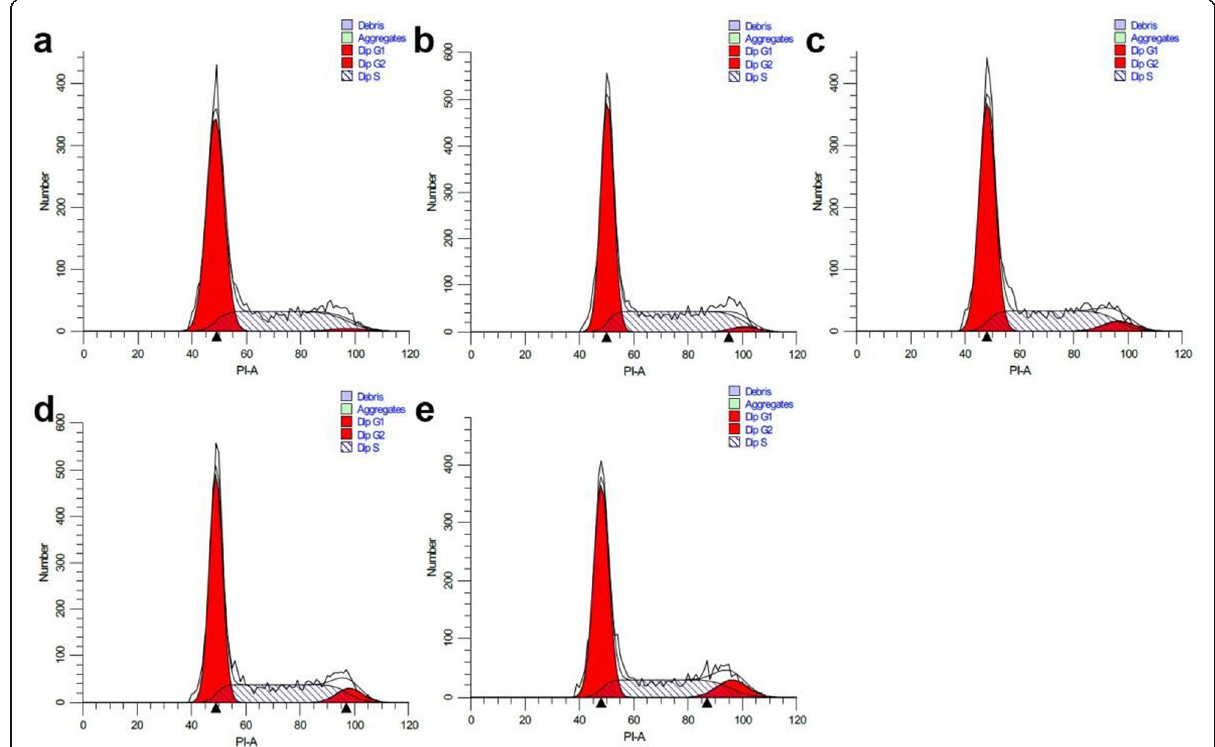
Fig. 2 Effects of CTL on the cell cycle of A549 cells. The cells were treated with varying concentrations of CTL ( a-e : 0, 10, 20, 30 and 40 μ g/mL) for 48 h. The A549 cells were stained with propidium iodide (PI) before FACS Calibur flow cytometry